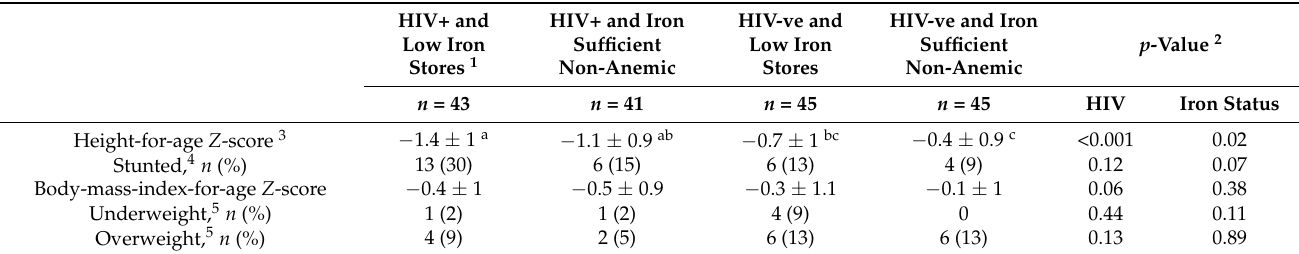
Table 2. Anthropometric status in the four groups of South African children purposefully selected according to HIV and iron